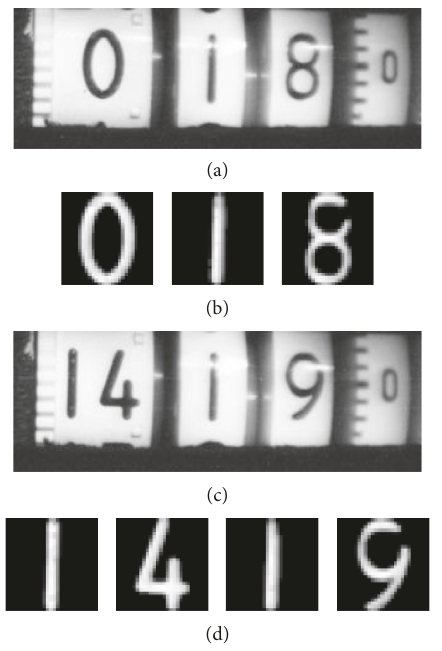
Figure 11: Original image (a, c) and segmentation result (b, d), respectively. As shown in figure (b, d), the recognition result is correct, even though the fourth character is partially split.